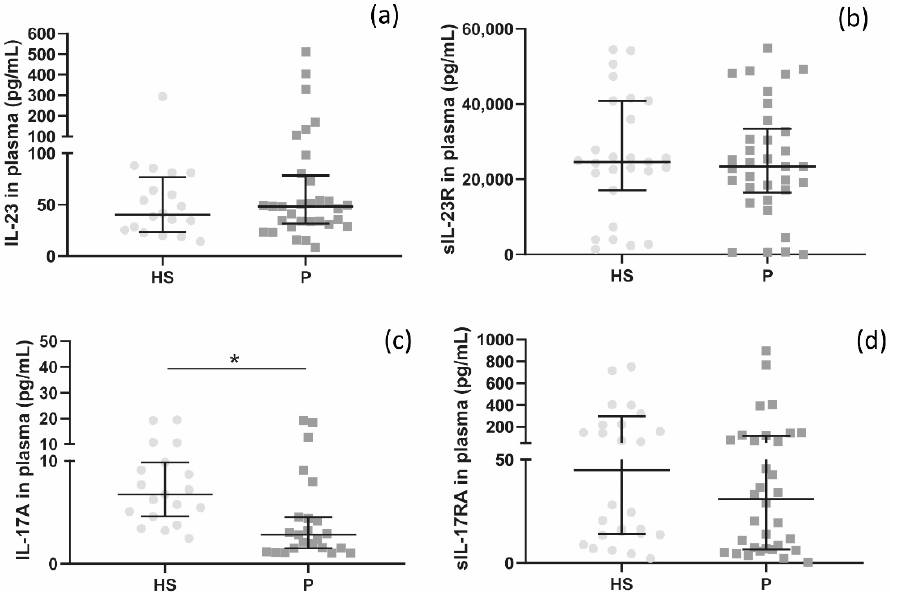
Figure 1. IL-23, IL-17A, sIL-23R, and sIL-17RA levels in plasma. plasma levels of IL-23 ( a ), sIL-23R ( b ), IL-17A ( c ), and sIL-17RA ( d ) from healthy subjects (HS) and periodontitis patients (P) were detected by ELISA and are expressed as pg/mL. The results are shown as median and interquartile ranges. * A p -value ≤ 0.05 was considered significant.